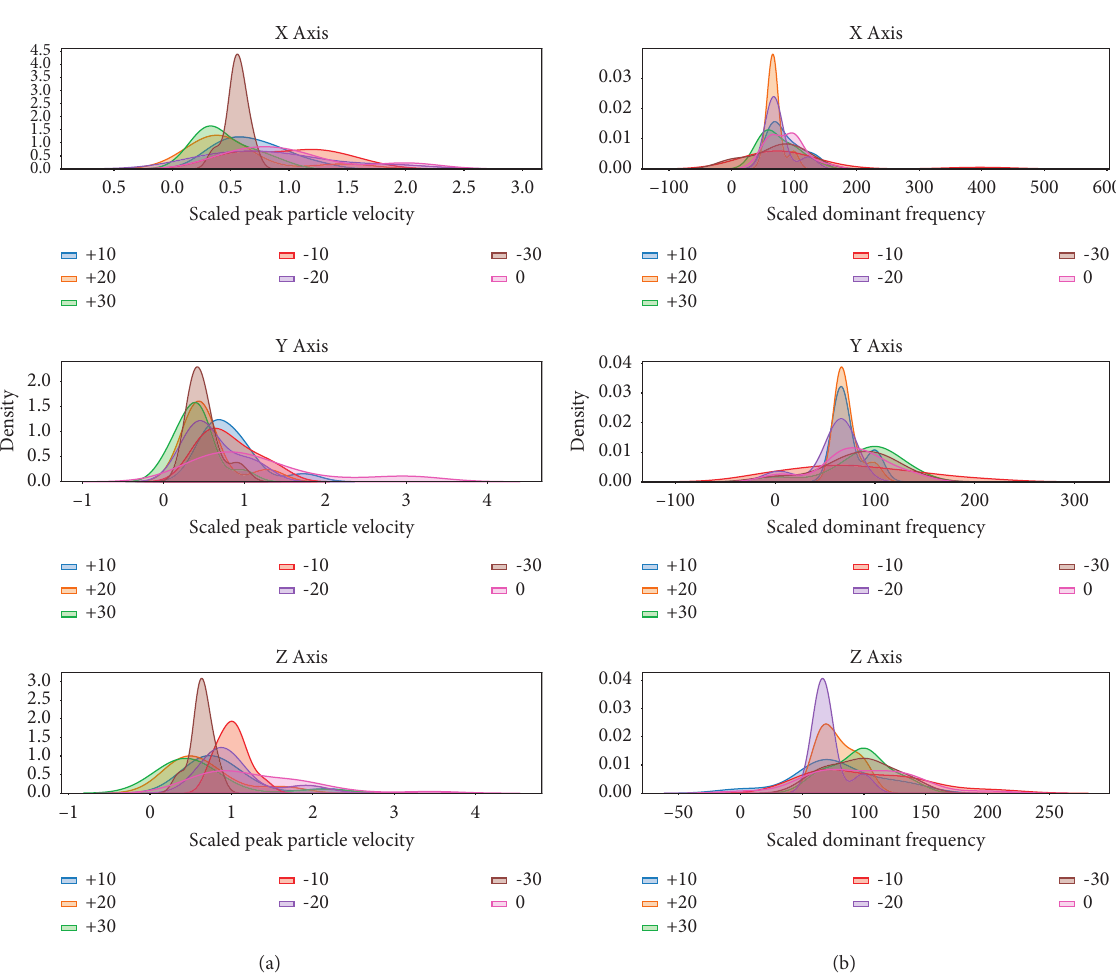
Figure 12: PPV and dominant frequency kernel density plots: (a) PPV; (b) dominant frequency.